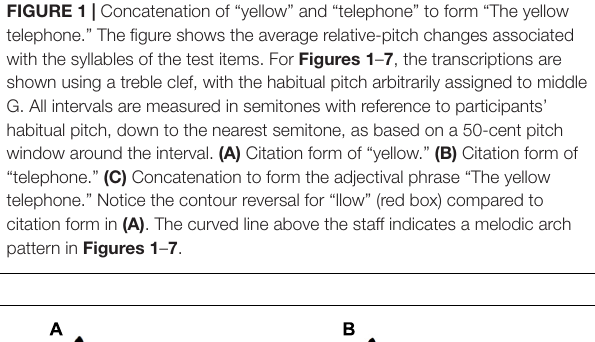
pattern in Figures 1 – 7 .